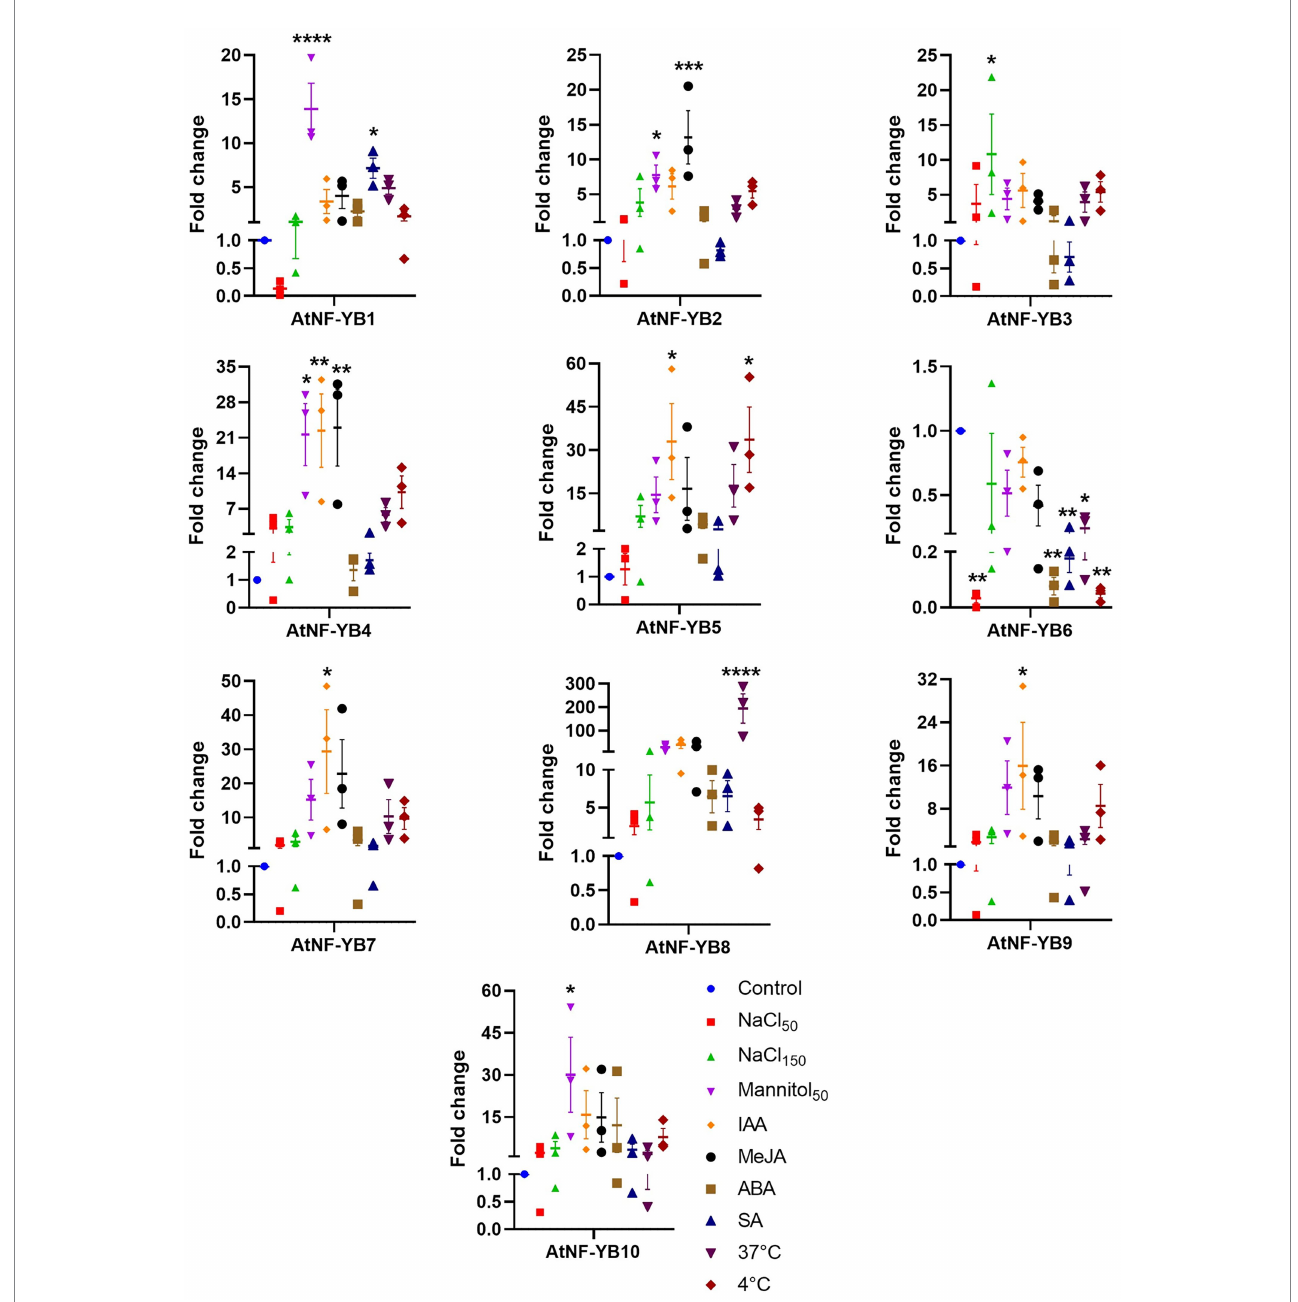
FIGURE 8 Expression analysis using qRT-PCR of all 10 AtNF-YBs under selected stressors. Arabidopsis thaliana (Col-0) wild type was used for control and treatment experimental sets. Experiments were performed in triplicates and GraphPad Prism 9.4.1 was used for the